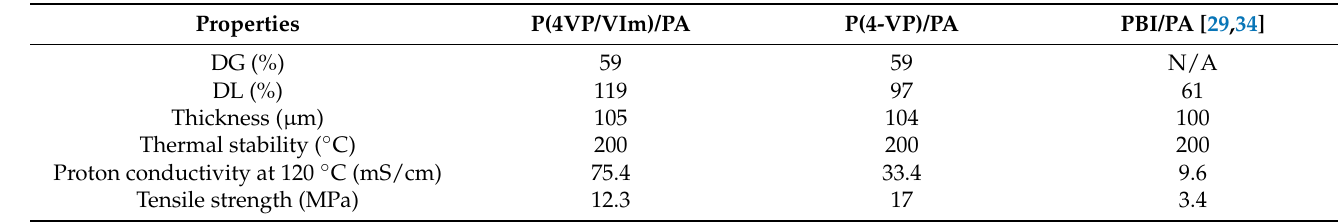
Table 2. Summary of the properties of ETFE- g -P(4-VP/1-VIm)/PA and ETFE- g -P(4-VP)/PA membranes.